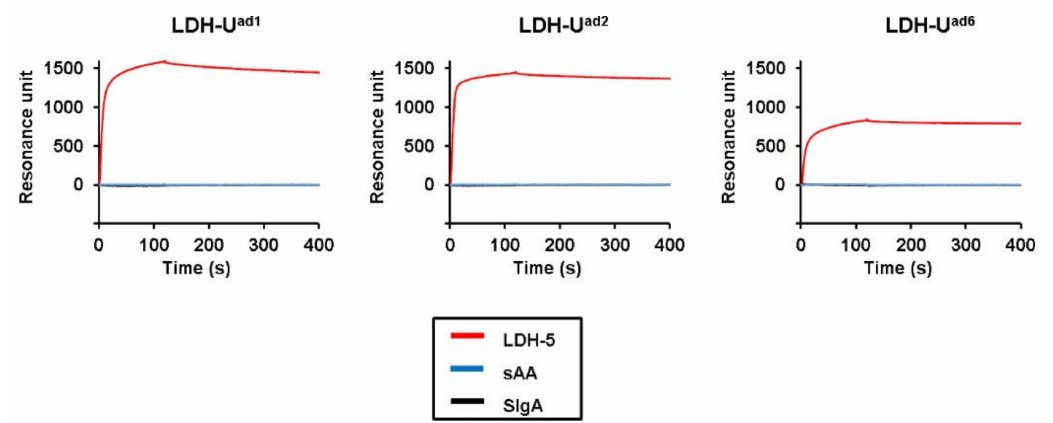
Figure A3. SPR response curve of the interaction between either LDH-5 or the salivary proteins SIgA and sAA and the candidate aptamers LDH–U ad1 , U ad2 , and U ad6 . LDH-5, SIgA, or sAA (400 nM each) were injected over the respective aptamer-immobilizing sensor chips for 120 s at a flow rate of 50 µ L / min. The red line represents the LDH-5 measured curve, while the blue and black lines represent the sAA and SIgA recorded curves, respectively.